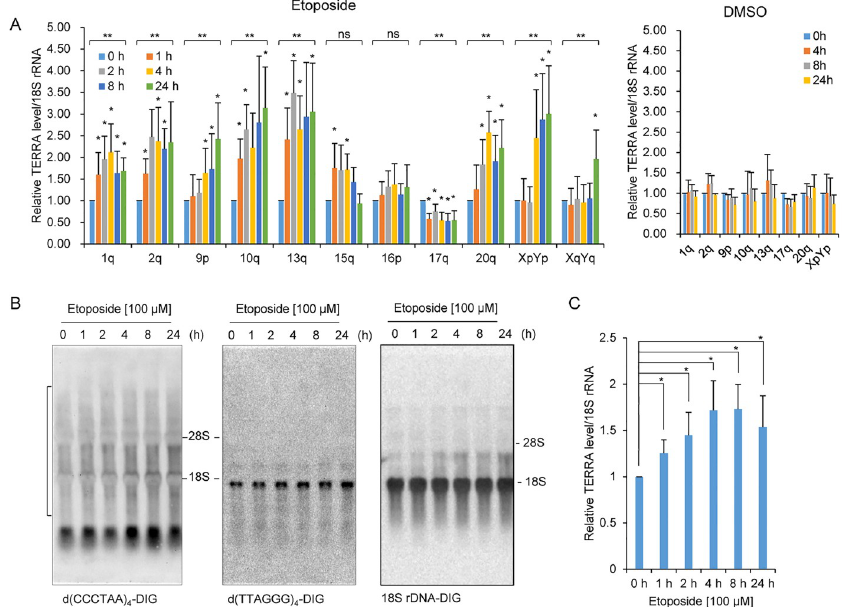
Fig 2. Increased levels of TERRAs in etoposide-treated HeLa cells. A. RT–qPCR analysis of TERRAs. HeLa cells were treated with 100 μ M of etoposide or vehicle alone (DMSO) for the indicated times. TERRAs were measured using RT–qPCR with 11 pairs of subtelomere-specific primers as indicated. The levels of TERRAs were normalized to 18S rRNA and compared with 0 h. Error bars are SD derived from at least three independent assays. Mann-Whitney U -test was used to compare TERRA levels between each time point and 0 h; an asterisk ( � ) on the bars denotes P < 0.05. One- way ANOVA was used for comparing TERRA levels at various incubation times for each representative subtelomere; �� P < 0.05, and ns P � 0.05. B. Northern blot analysis of TERRAs. Total RNAs were isolated from HeLa cells treated with etoposide for the indicated times. The DIG-labeled probes used in hybridization are indicated. The membrane was reprobed after stripping off the previous probes. Size markers, 28S and 18S rRNAs, are indicated. The d (CCCTAA)4-DIG-specific diffuse bands, indicated by a bracket, were quantified, normalized to 18S bands, and compared with 0 h. C. Quantification of northern blot analyses in B (mean ± SD; n = 4). One-way ANOVA was used for comparing TERRA levels according to different incubation times ( P = 0.004). Mann-Whitney U -test was used to compare differences in TERRA levels between each time point and 0 h; � P <